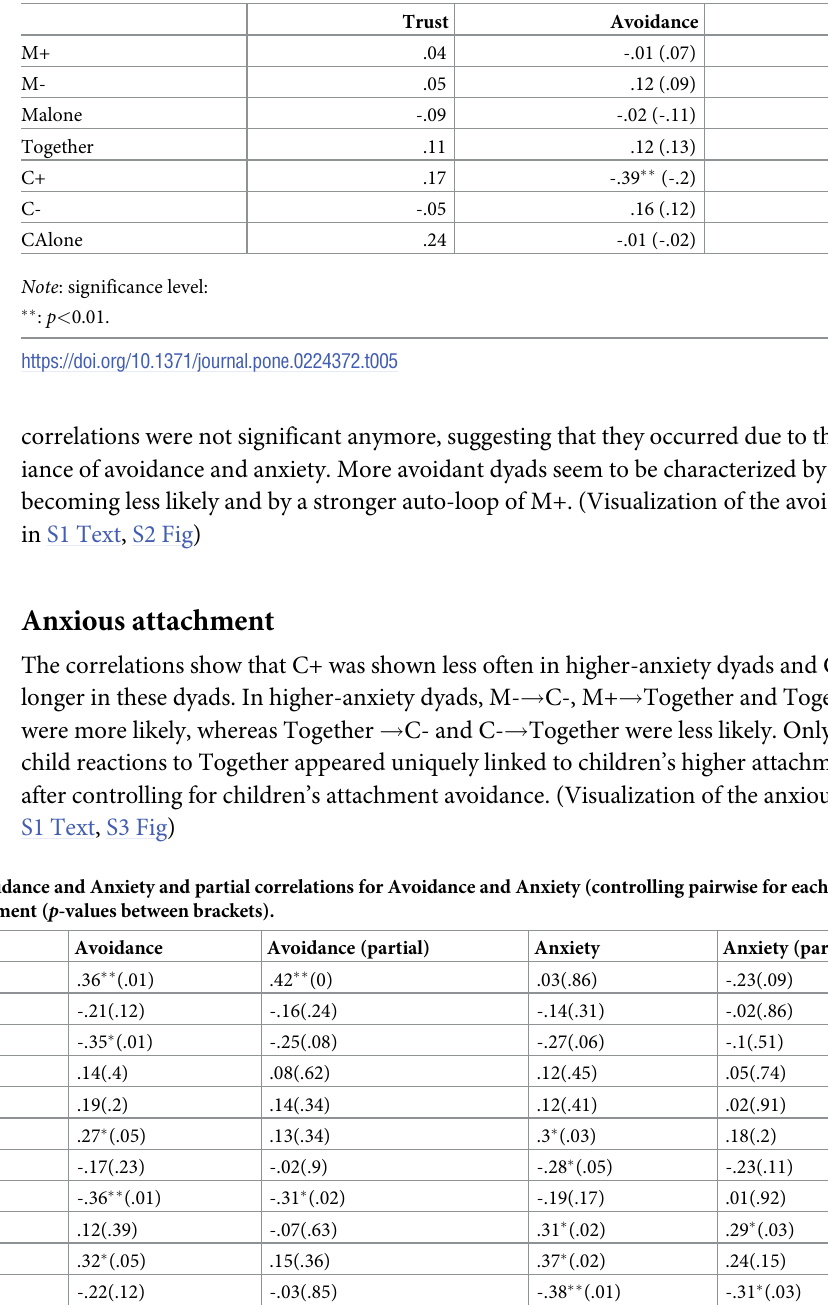
Table 5. Correlations between relative frequency of behavior and self-reported attachment (for Avoidance and Anxiety partial correlations–correcting for each other—are provided in brackets).